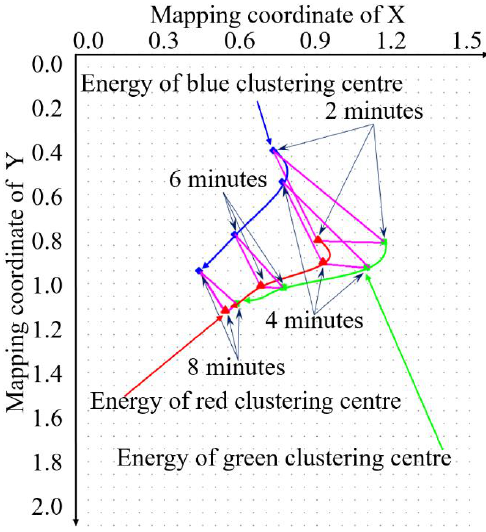
Figure 13. Variation of energy clustering trend of training samples with different fixation time.